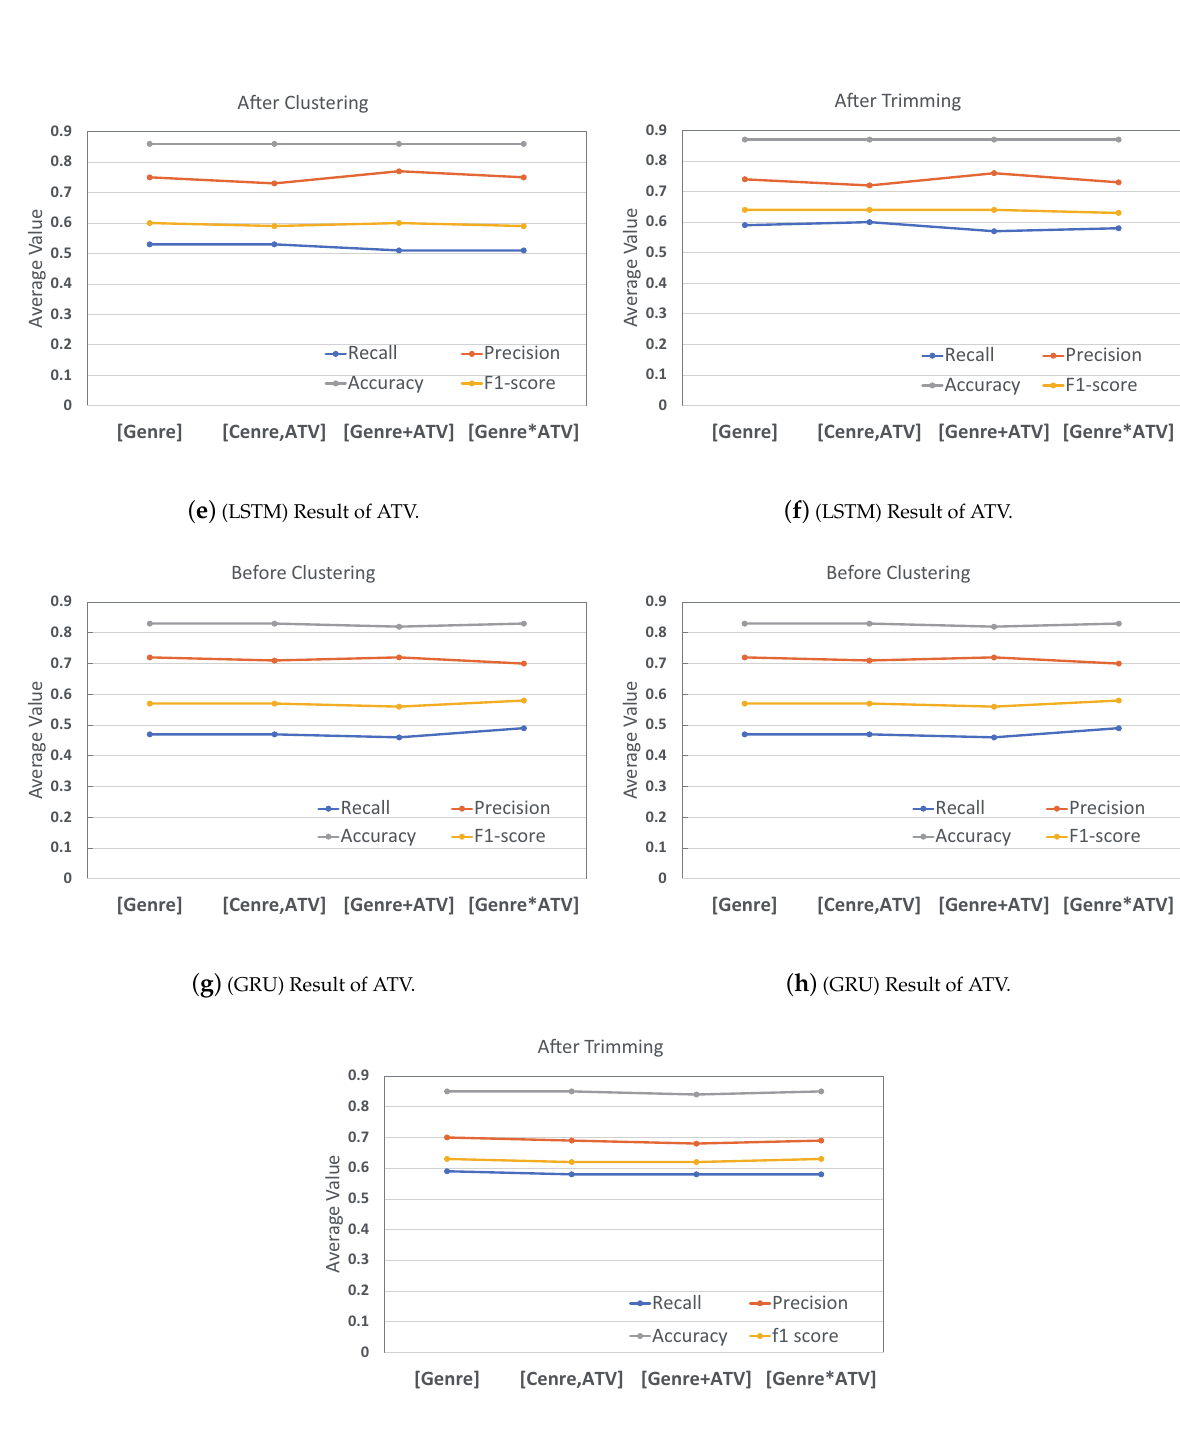
( i ) (GRU) Result of ATV. Figure 13. Result of ATV for RNN ( a – c ), LSTM ( d – f ), and GRU ( g – i ),